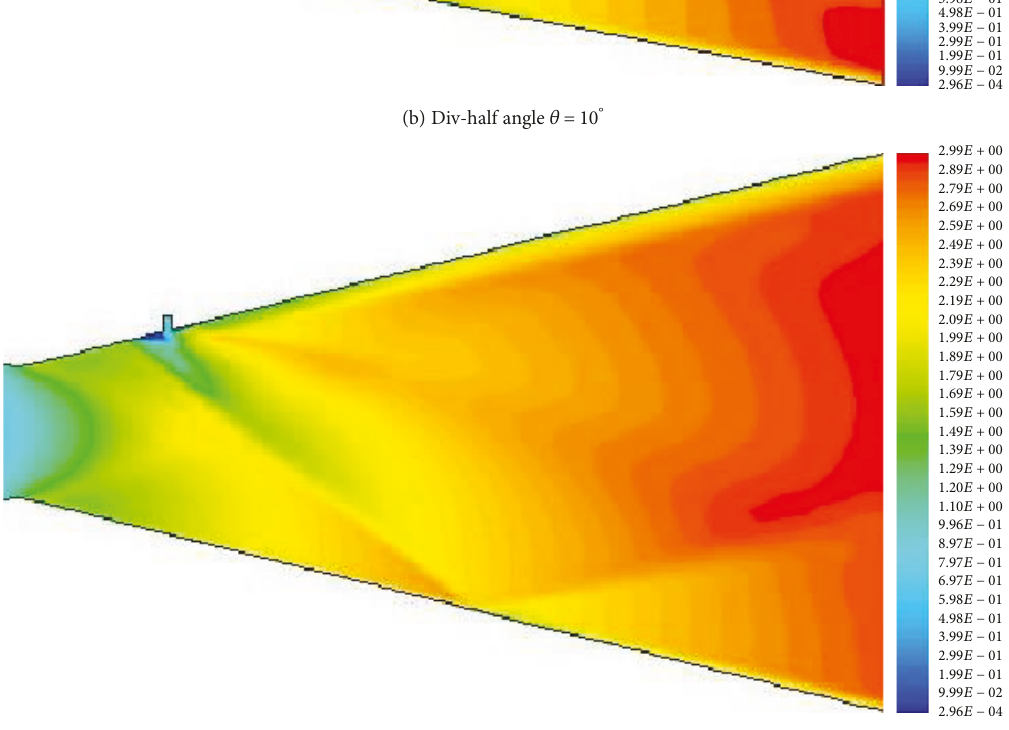
Figure 21: The in fl uence of primary nozzle divergence half angle on fl ow fi eld structure (Mach number contour) M